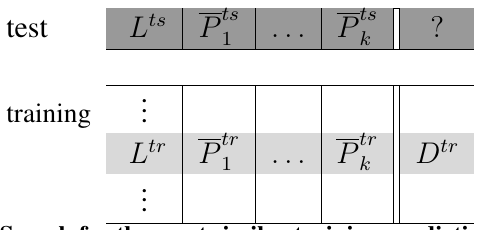
Figure 2: Search for the most similar training prediction